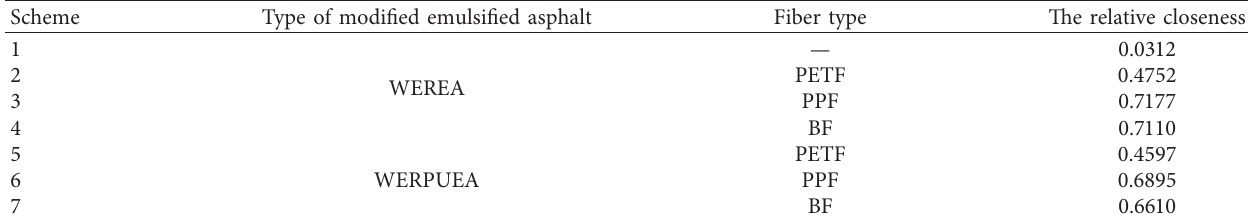
Table 7: The relative closeness of each